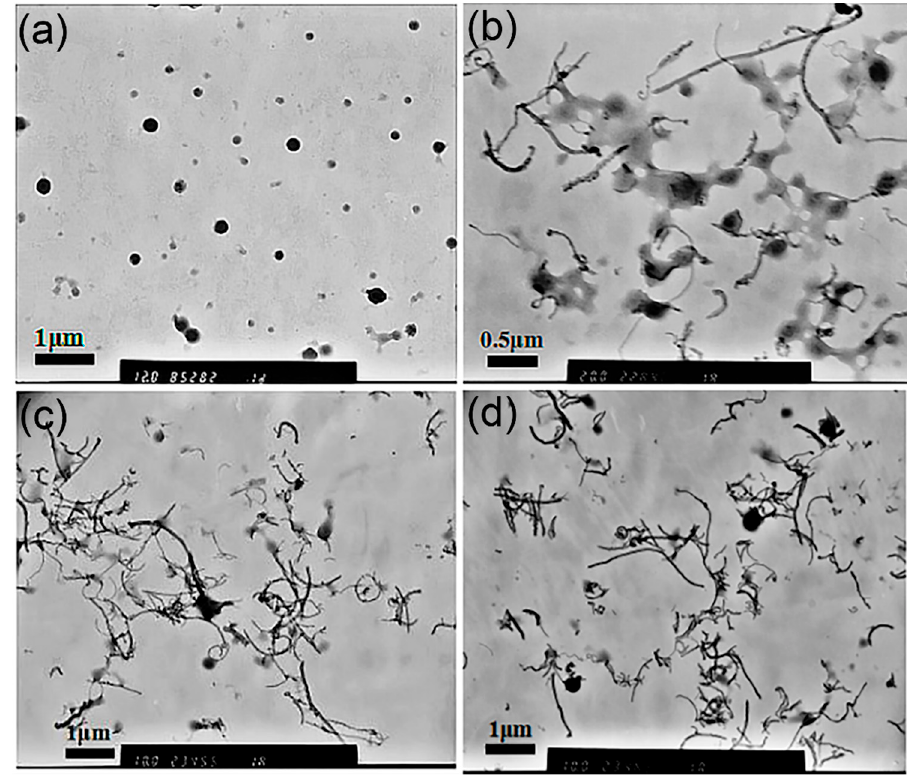
Figure 7. Transmission electron microscopy (TEM) images of drug-loaded MPEG-PDLLA/c-MWCNT nanocomposites obtained at different mass ratios of c-MWCNTs (tube diameter >30 nm, length 0.5~2 µ m) to MPEG-PDLLA: ( a ) 0; ( b ) 0.05:1; ( c ) 0.2:1; ( d ) 0.3:1.